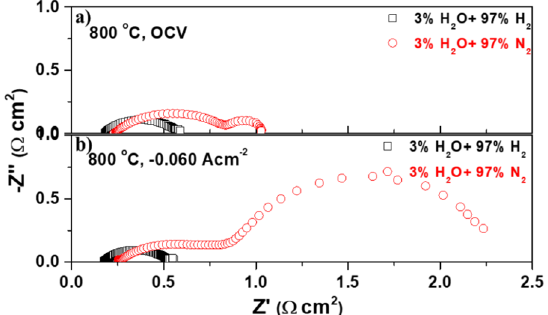
Fig. 2 Electrochemical impedance spectra recorded at 800 °C for SFM-SDC/LSGM/SFM-SDC symmetrical cell operated at a OCV and b − 0.060 A/cm 2 with humidified N 2 and H 2 as the cathode gases, respectively